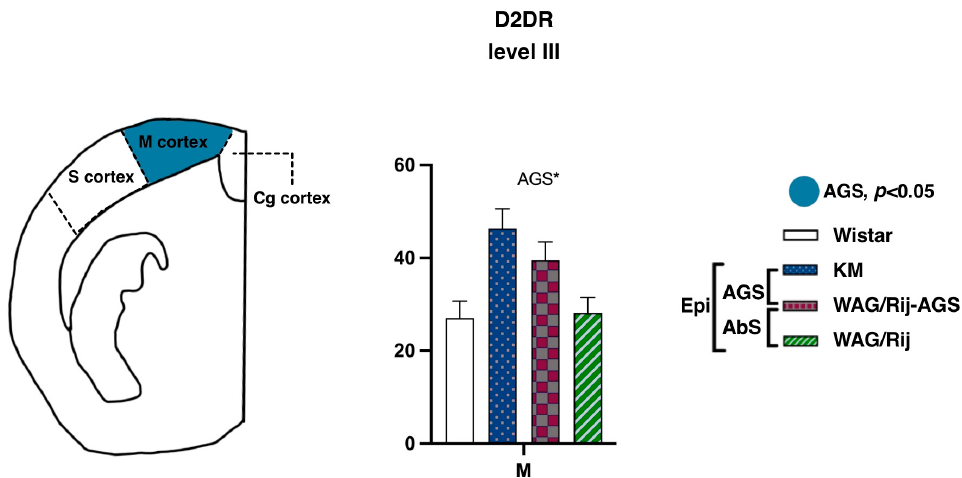
Figure 6. Comparisons of the cortex binding densities to D1DR and D2DR. The values are given as mean ± SEM, in pmol/g of tissue. For anatomical levels and abbreviations, see Figure 3. Differences are shown by ‘*’ for p ≤ 0.05. Effects of audiogenic epilepsy are marked by the “AGS”